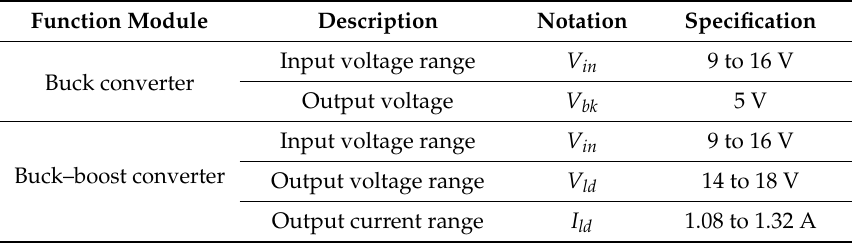
Table 3. LHES specification.